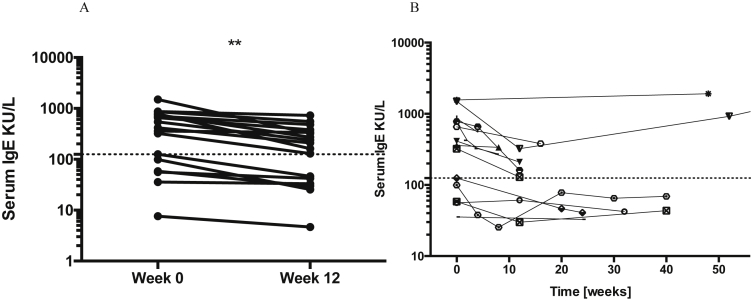
Serum IgE and relationship to corticosteroid therapy in IgG4-RD. (A) Serum IgE concentrations in IgG4-RD patients at diagnosis before corticosteroids (0 weeks) and after 12 weeks of corticosteroid therapy (n = 15). On the y-axis is serum IgE concentrations kIU/L. Dashed line is the upper limit of IgE (≥125 kIU/L). Two-tailed paired Student t test P values, where **P < .01. (B) Serum IgE concentrations in IgG4-RD patients during follow-up over 12 months of corticosteroid therapy. The dashed line is the same as in A.